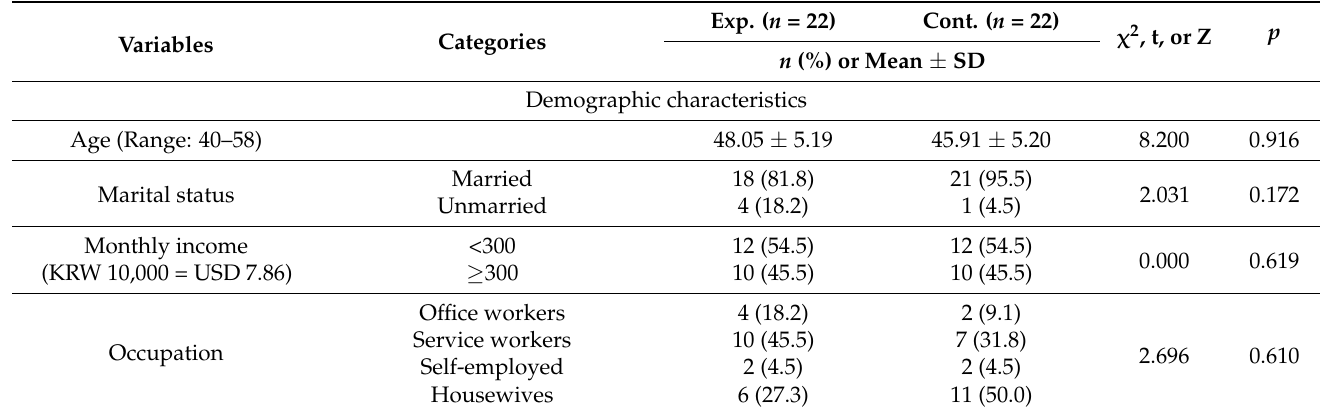
Table 2. Between-group comparisons of general characteristics and outcome variables at baseline ( N =